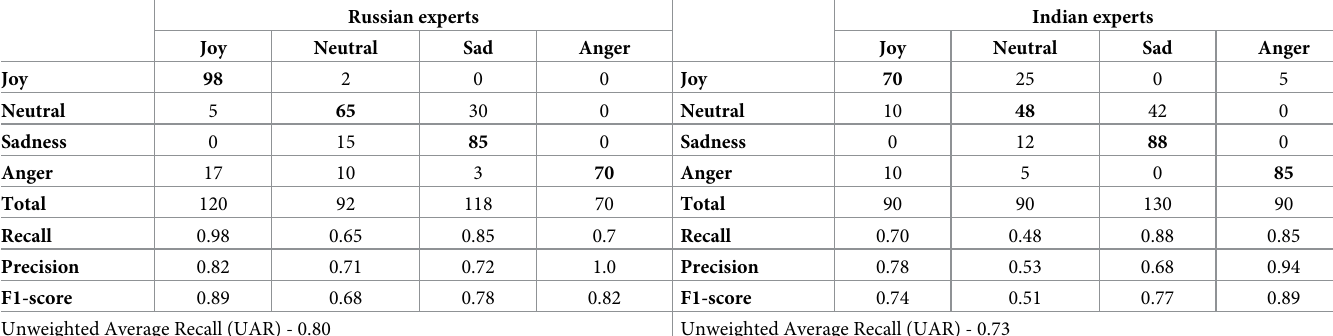
Table 10. Confusion matrix for emotion classification in the meaningless text of Russian children by Russian and Indian experts. Russian